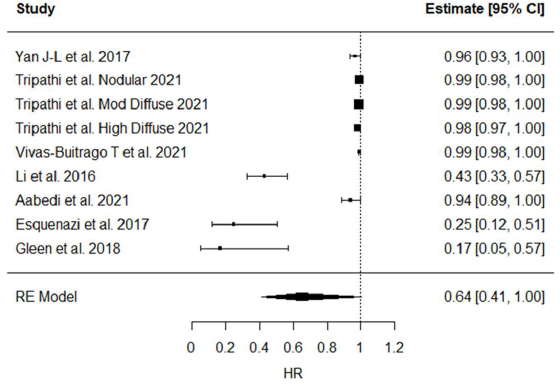
Figure 1. OS HRs Pooled Meta-Analysis.